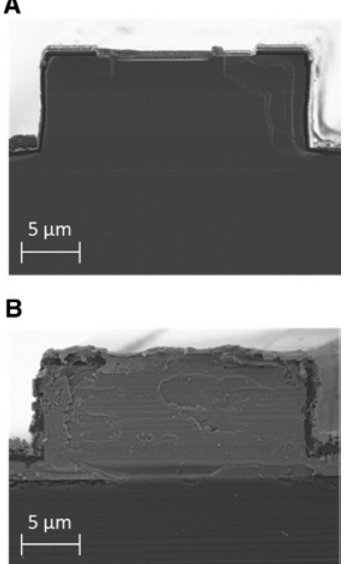
Figure 10: Scanning electron microscope images: the reference InP device (A) and the Si device (B) [59].